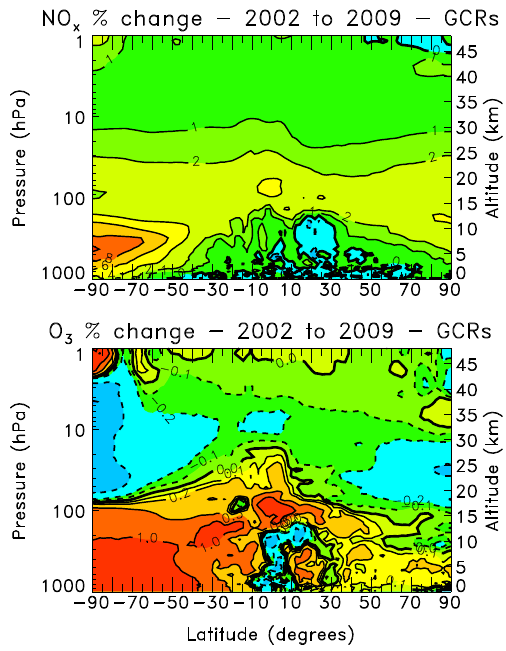
Figure 6. Annual average percentage change for year 2009 in zonal mean HO x (top) and HNO 3 (bottom) due to GCRs in the SD- WACCM (simulation Base_SD_W compared to GCR_SD_W ). The contour intervals for the HO x changes are − 6, − 4, − 2, − 1, 0, and 1%. The contour intervals for the HNO 3 are − 1, 0, 1, 2, 5, 10, 15, and 20%.